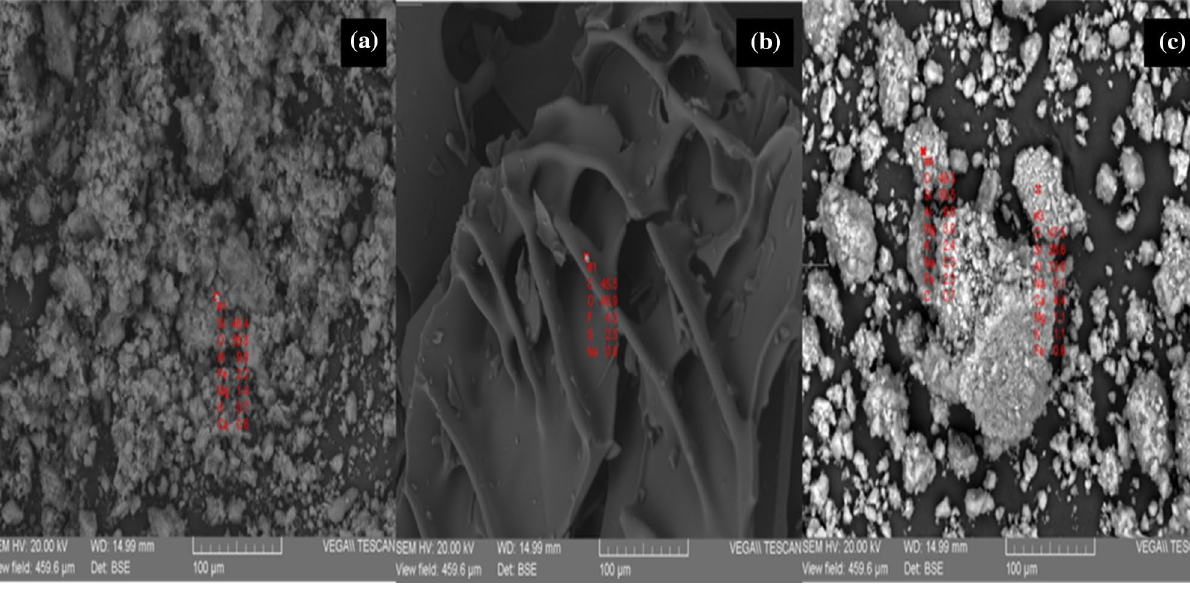
Fig. 3 SEM microphotographs of DC ( a ), BSA ( b ) and BSA adsorbed DC ( c ) after 120